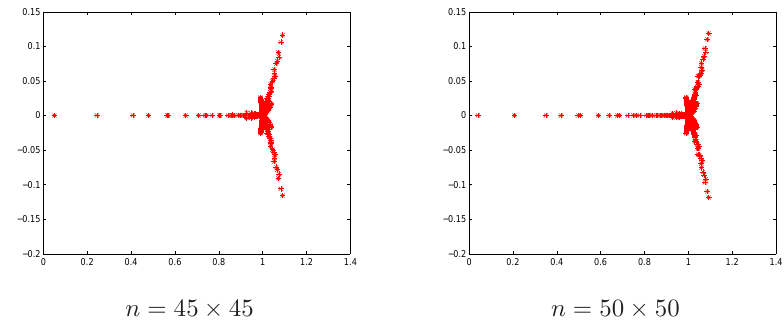
Figure 1. The spectrum of the preconditioned matrix M − 1 A with λ = 17